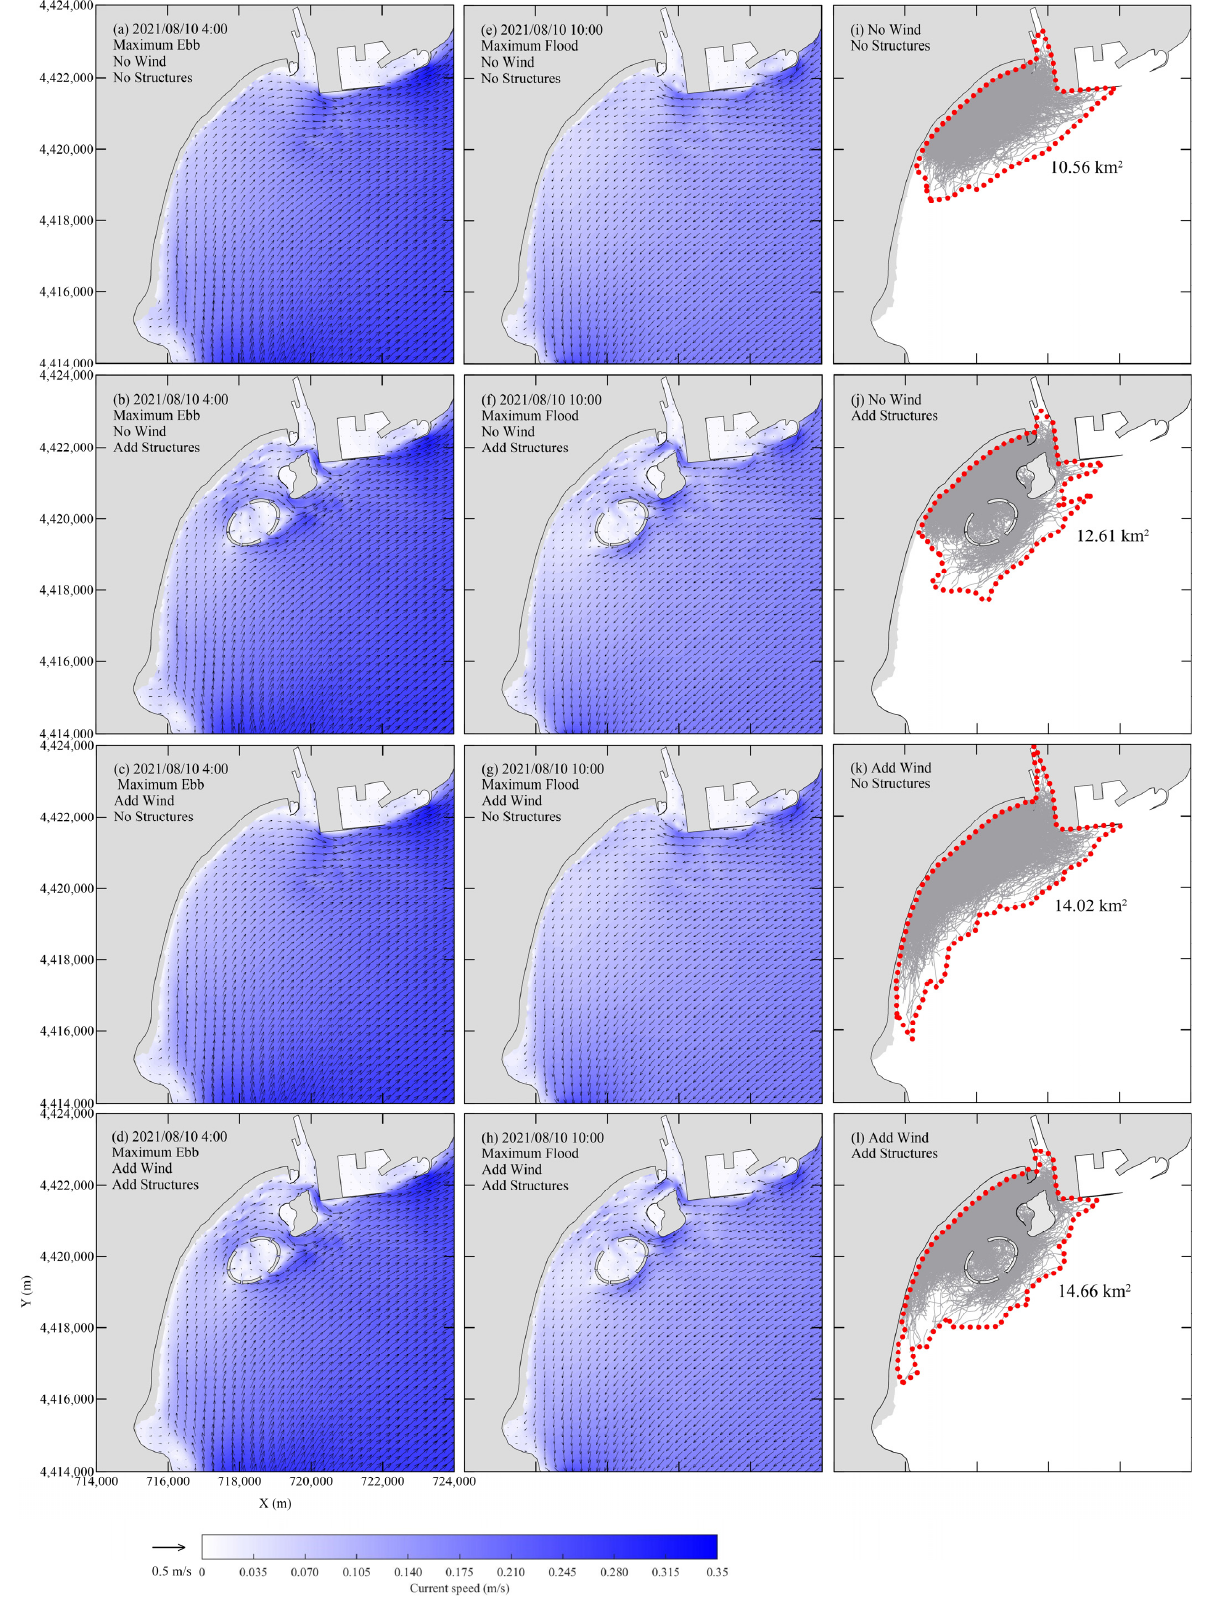
Figure 9. ( a – h ) Current fields with or without winds and structures in the moments of maximum ebb and flood; ( i – l ) Trajectories of green macroalgae with or without winds and structures. The areas surrounded by dotted red lines represent the coverage of the green macroalgae